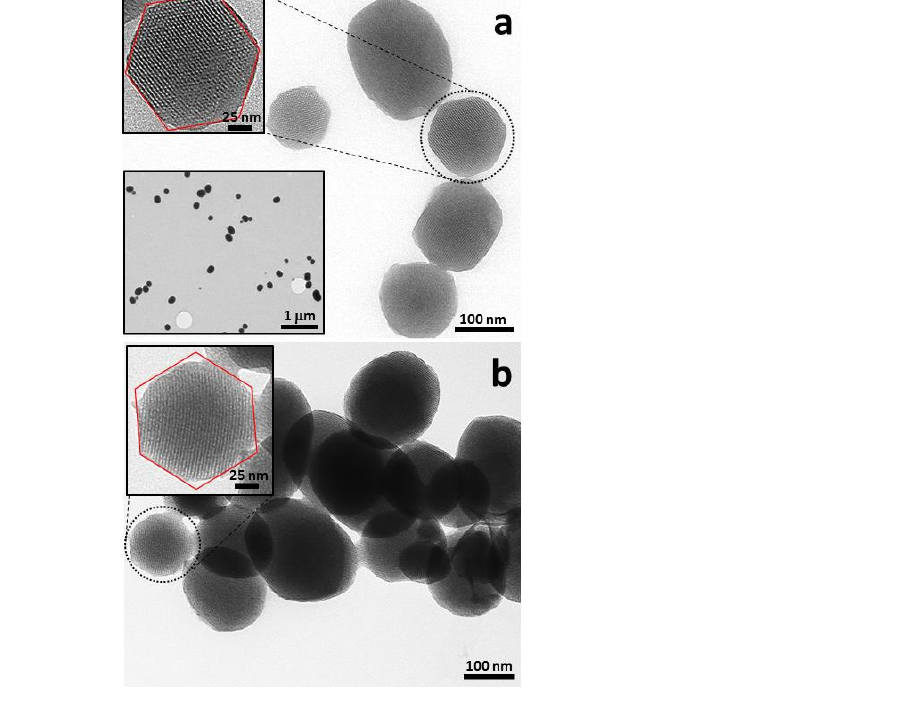
Figure 3. Transmission electron microscopy (TEM) images of the starting MCM-41 ( a ) and the S1 solid ( b ).